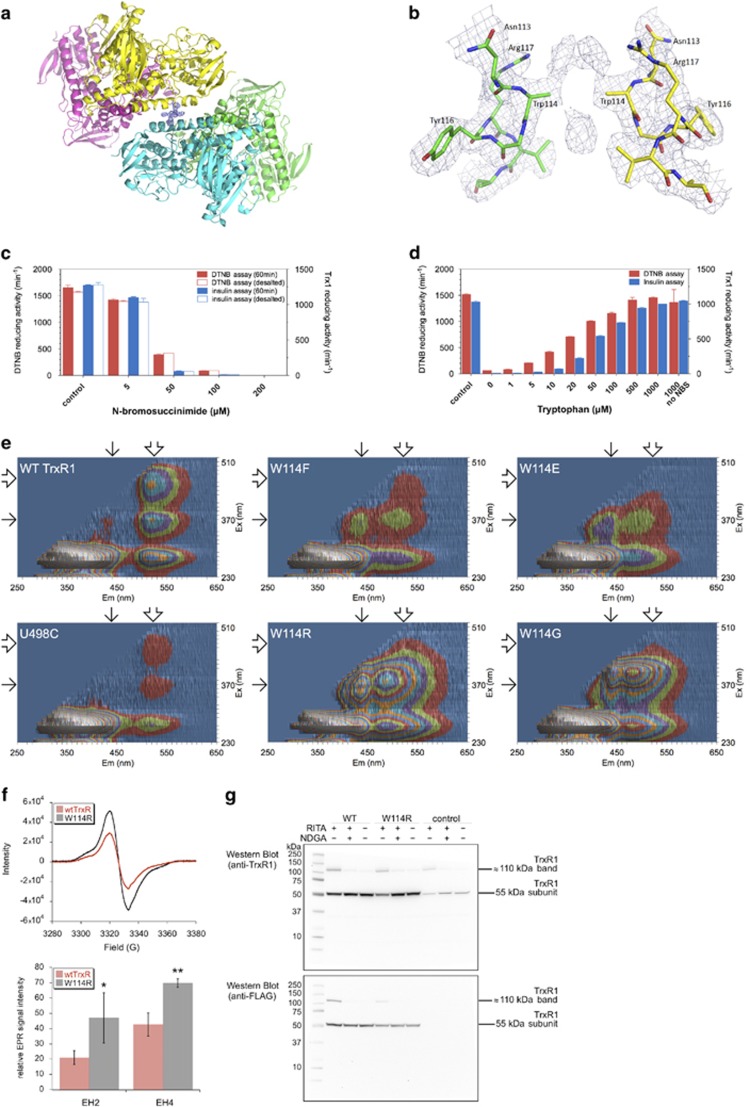
Surface-exposed Trp114 links TrxR1 dimers into tetramers, communicates with the FAD and is required for full enzyme activity. (a) Crystal structure of the TrxR1 tetramer, showing two dimers (yellow/purple and green/blue) linked together by the interaction of two modified Trp114 residues (middle, surface between the yellow and blue subunits of the two separate dimers; here with their modified side chains indicated by the composite omit electron density map). (b) Close-up of the final 2Fo-Fc map at 1σ of the region where two modified Trp114 side chains link the two TrxR1 dimers in the tetramer structure (one dimer here colored green and the other yellow). The electron density spanning the linkage could not be modeled with any known modifications of Trp residues and the Trp114 side chains are therefore only shown as electron density. Neighboring residues from each dimer are indicated with their three letter codes. (c) NBS irreversibly inhibits TrxR1. For this experiment, wild-type dimeric TrxR1 was incubated in the dark with NBS at the indicated concentrations for 60 min, desalted and subsequently enzyme activities were measured with either DTNB or Trx-dependent insulin reduction. (d) Free Trp in solution protects TrxR1 from inhibition by incubation for 120 min with 50 μM NBS. (e) 3D fluorescence excitation/emission spectra reveal long-range communication between Trp114 and FAD. Typical enzyme-bound flavin fluorescence53 at Emmax≈520 nm has three excitation peaks of Exmax≈280 nm, ≈370 nm and ≈470 nm as seen in wild-type TrxR1, whereas one of these fluorescence peaks, Exmax≈470 nm/Emmax≈520 nm (block arrows), was virtually absent in the Trp114 variants, where instead a new peak at Exmax≈370 nm/Emmax≈440 nm was seen (thin arrows). (f) Representative EPR analysis of wild-type TrxR and the W114R variant. For these spectra, TrxR (300 μM dimer) was incubated with 900 μM NADPH for 80 s. In the absence of NADPH, the oxidized enzymes did not show this signal, nor did NADPH without enzyme. The bar graph at right shows the relative EPR signal intensities of wild-type TrxR (wtTrxR) and the W114R variant incubated with an excess of NADPH to generate the reduced (EH4) state of the enzyme, or with a limiting amount of NADPH to generate a partially reduced (EH2) state. *P<0.05 or **P<0.01 for W114R versus wtTrxR. EPR instrument settings are described in the Materials and methods section. (g) Immunoblot detection of different TrxR1 species with antibodies against either TrxR1 (top) or the FLAG-tag (bottom) as resolved on reducing SDS-PAGE analyses with lysates from HCT116 cells transfected for expression of FLAG-tagged wild-type TrxR1 (WT), the W114R mutant or non-transfected controls, treated with either RITA, RITA and NDGA or using non-treated control cells (as indicated)